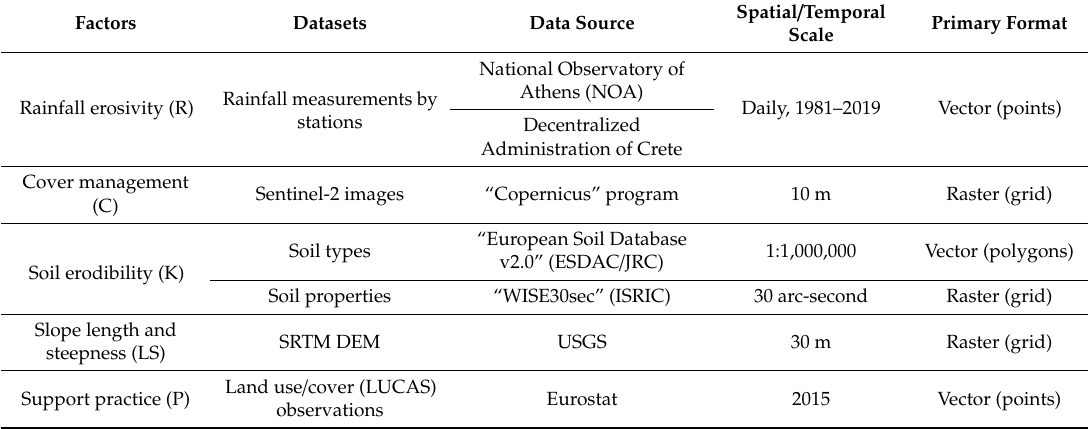
Table 1. Summary of input datasets used in Revised Universal Soil Loss Equation (RUSLE)